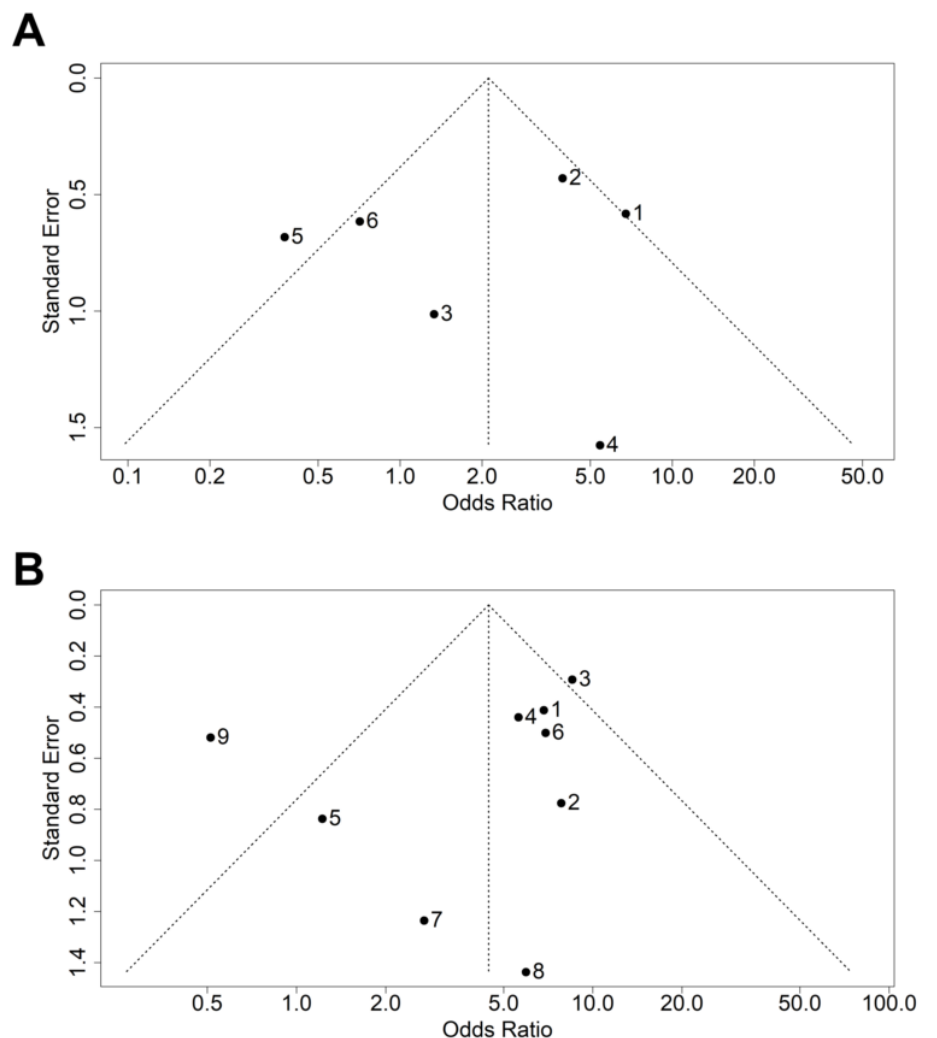
Figure 3. Funnel plot representing publication bias in the studies involving ( A ) m.4216T>C variant and ( B ) m.13708G>A variant.